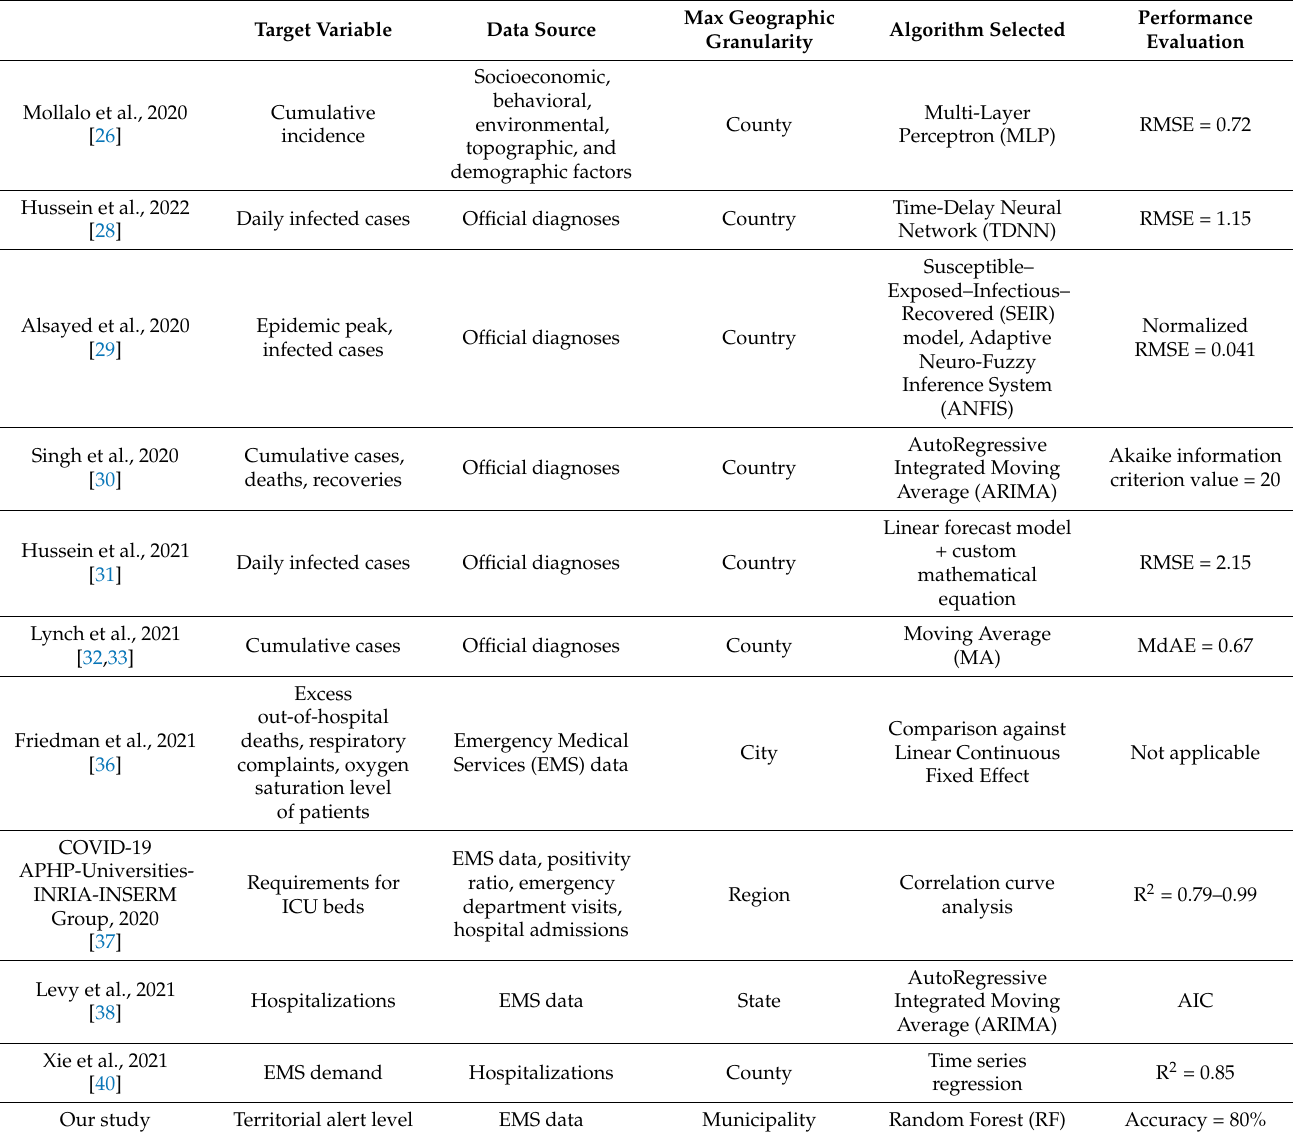
Table 1. Main relevant features of similar studies in the scientific